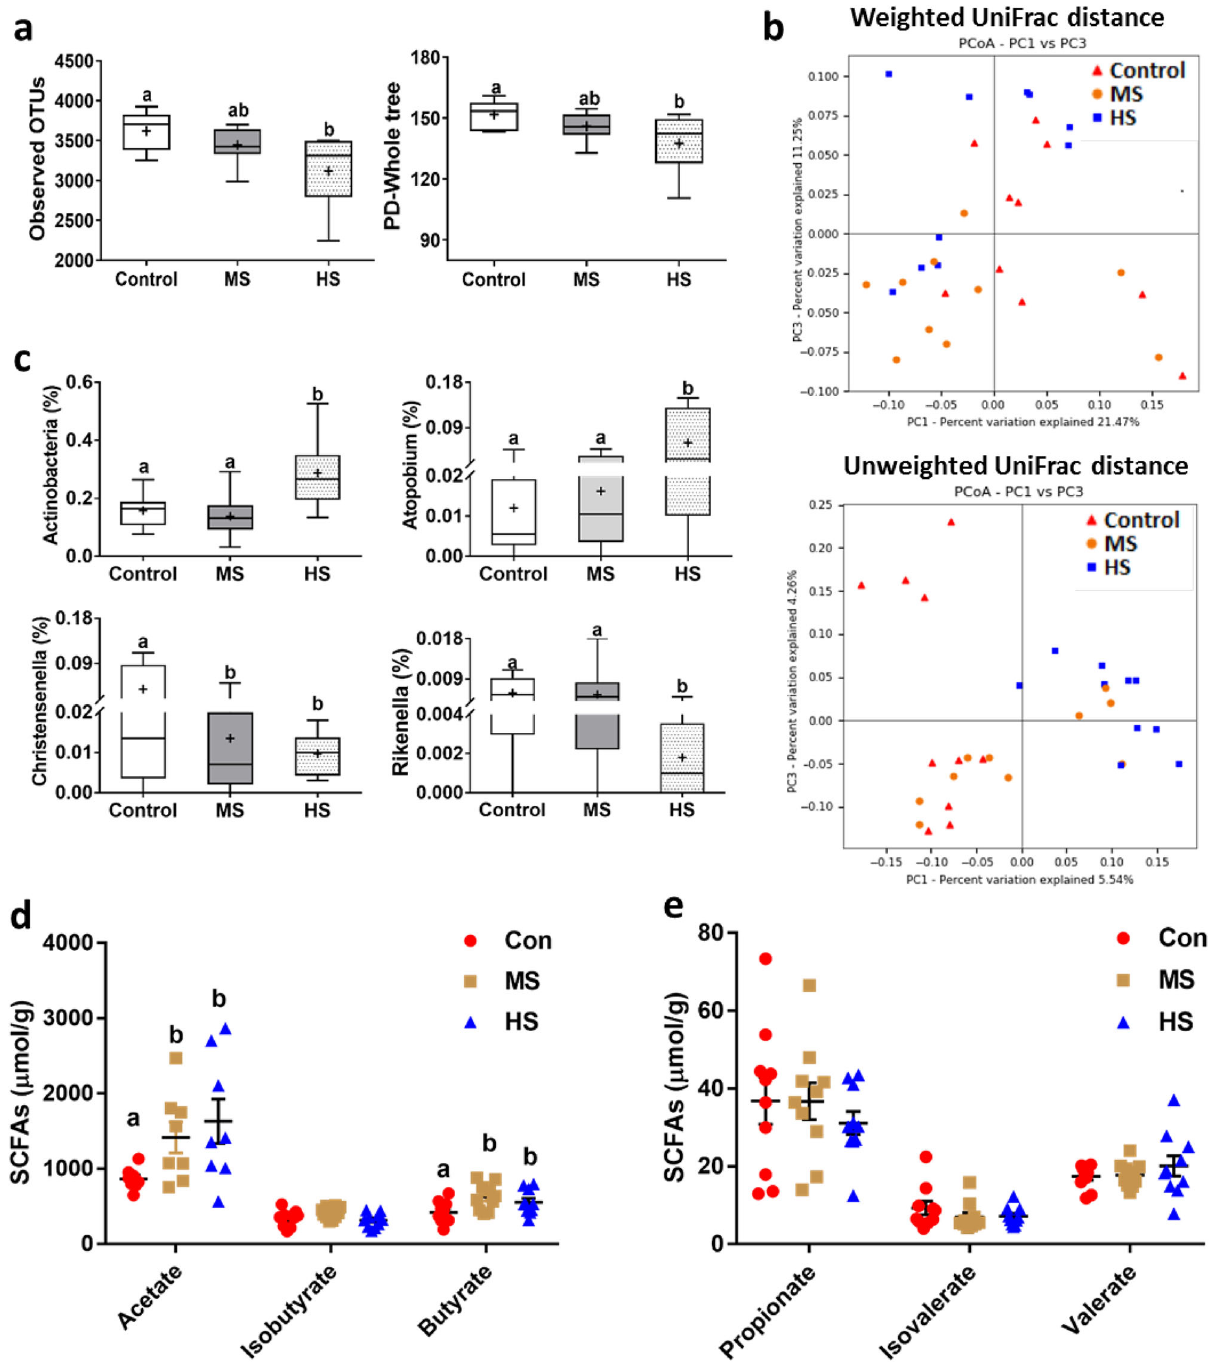
Fig. 1 Salt intake altered faecal microbiota. Alpha diversity indicated by observed operation taxonomic units (OTUs, P = 0.005), and phylogenetic diversity (PD) whole tree ( P = 0.013) ( a ); principal coordinate analyses (PCoA) plots based on weighted ( P = 0.001) and unweighted ( P = 0.001) UniFrac distances in faecal microbiota of different groups ( b ); relative abundances of different bacteria at the phylum and genus levels in different experimental groups ( “ + ” indicates the mean value) ( c ); and concentrations of different short-chain fatty acids (SCFAs) ( d , e ) in control (Con), medium salt (MS), and high salt (HS) gerbils. Data are presented as means ± standard error of the mean (s.e.m), and the bars which do not share the same letter are signi fi cantly different from each other ( P < metabolism, we measured serum total bile acids and observed a method (Fig. 5d). Acetate concentration was higher in the HS than lower concentration in HS than Con gerbils (ANOVA, F 3, 28 = 7.047, Con group (ANOVA, F 3,28 = 7.582, P = 0.001; Fig. 5e); however, CMT (HS-Con) decreased acetate but increased butyrate concen- P < 0.001; Fig. 5g). With CMT, however, the concentration of the tration (ANOVA, F 3,28 = 5.509, P = 0.004; Fig. 5e). Other SCFA total bile acids was recovered. Even 16 weeks after CMT (in week 20), the α diversity of concentrations were not affected by salt intake or CMT (Fig. 5e, f). microbial community was still lower in HS than Con gerbils Since the gut microbiota are also involved in host bile acid